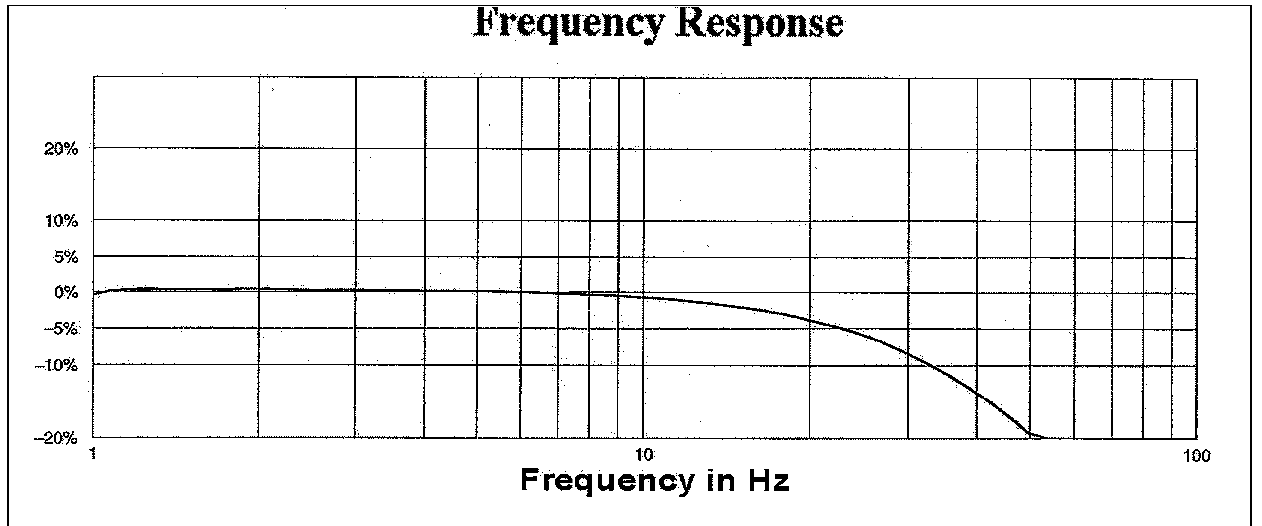
Figure 3. Calibration data (vertical